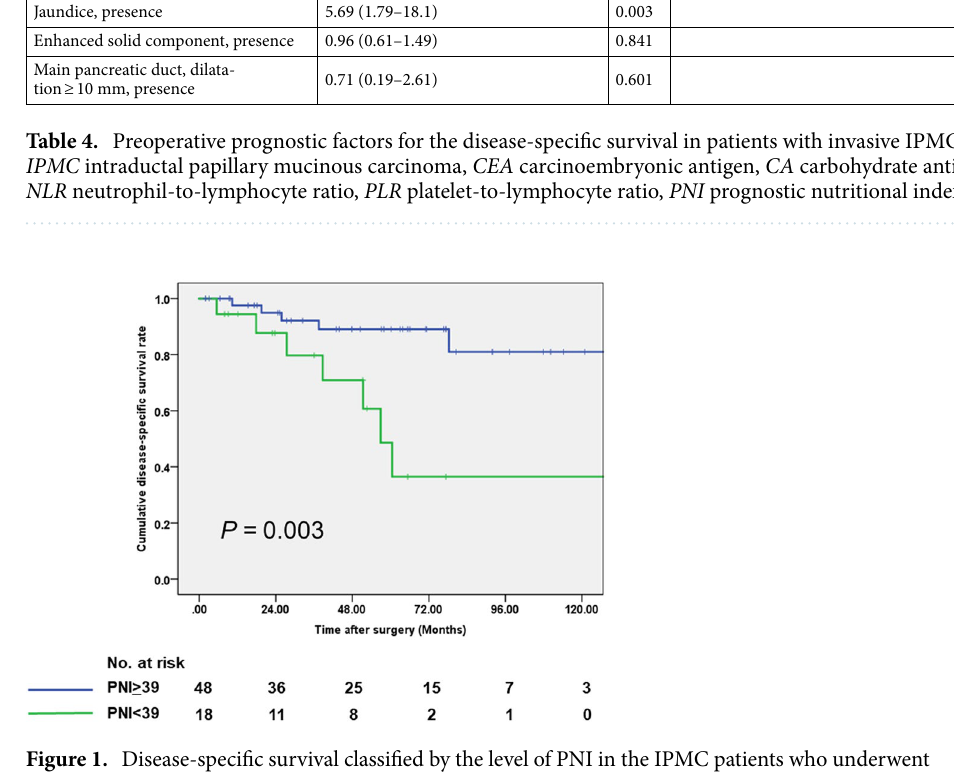
Figure 1. Disease-specific survival classified by the level of PNI in the IPMC patients who underwent pancreatectomy using the Kaplan–Meier method.